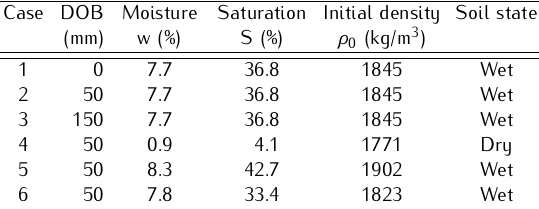
Table 7. Definition of simulation cases.